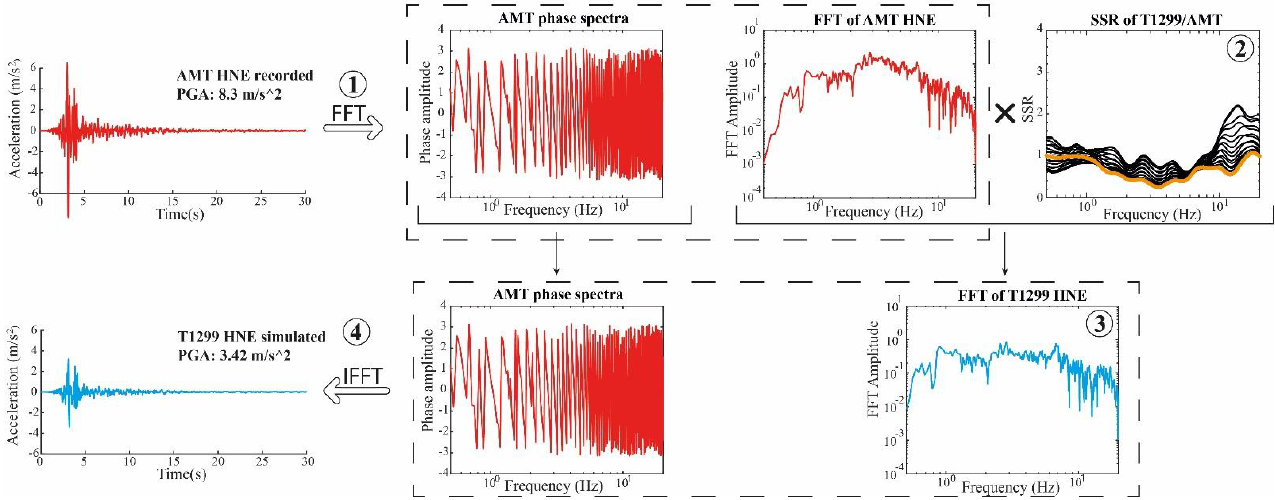
Figure 2. Simulation strategy proposed in this study, where numbers 1 to 4 refer to the numbered list of Section 3. Red lines represent the recorded time series and the relative phase and amplitude spectra at the reference station (AMT) for the Mw 6.5 earthquake. Number 2: orange thick line represents the standard spectral ratio (SSR) of T1299 (E–W component) with respect to AMT, thin black lines represent the 18 horizontal components of the SSR rotated every 10° and 1 vertical component. Numbers 3 and 4: blue lines represent the simulated signal at T1299 with its phase and amplitude spectra, respectively.